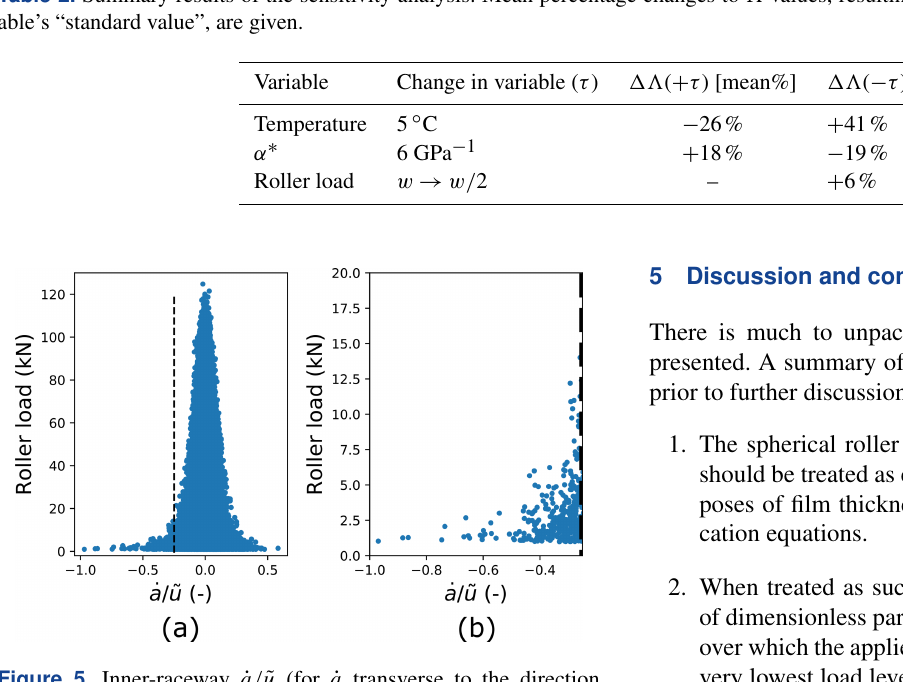
Figure 5. Inner-raceway ˙ a/ ˜ u (for ˙ a transverse to the direction of rolling), where ˙ a = d a/ d t , with values plotted against roller load. Results are only shown where roller loads exceed 1kN. Panel (a) shows all results, with a vertical dashed line included to indicate the − 0 . 25 threshold for potentially damaging non-steady effects. Panel (b) provides a close-up of data falling to the left of this